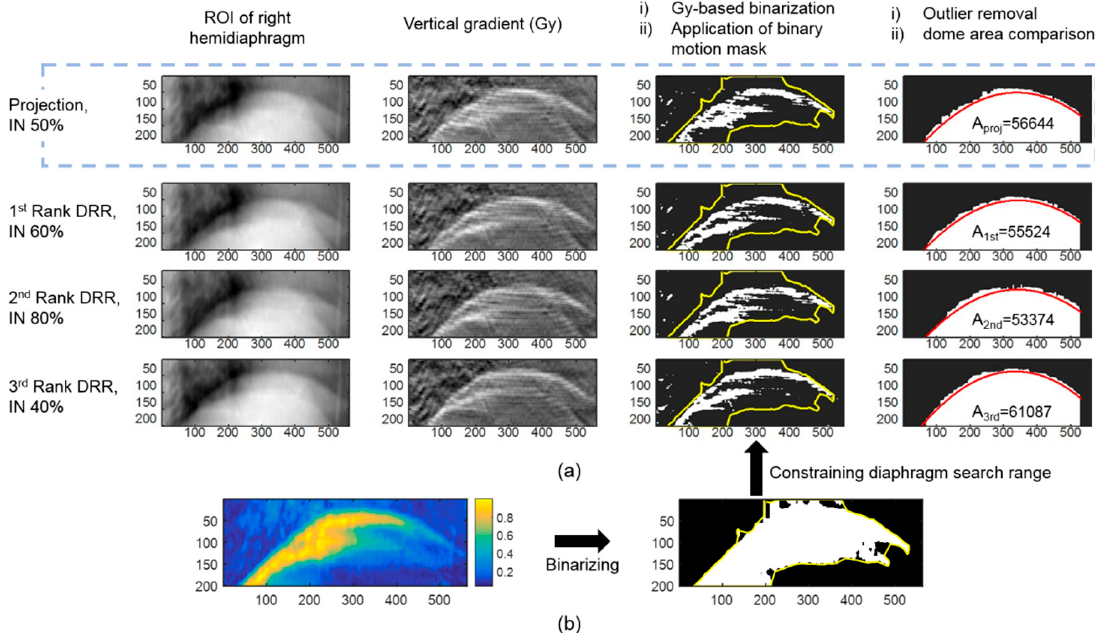
Figure 2. Procedure used to compare the diaphragm area on a 2D digitally rendered radiographs (DRR) or fluoroscopy. ( a ) Comparison procedures for the hemidiaphragm area of the projection with 1st, 2nd, and 3rd rankings. ( b ) Example of a binarized, dynamic pixel map used during the procedure.